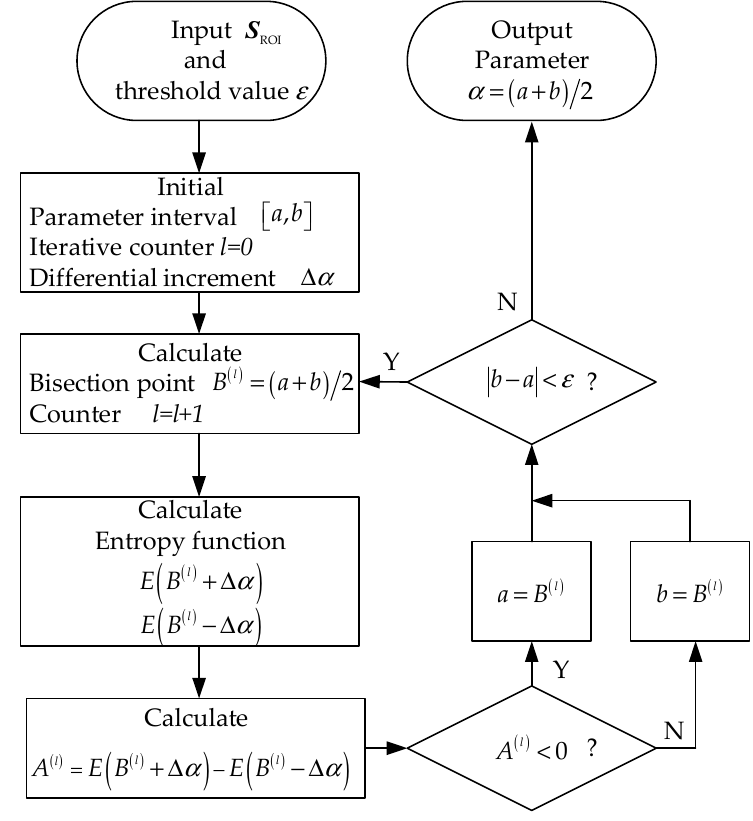
Figure 3. Flow chart of proposed MMEA method.